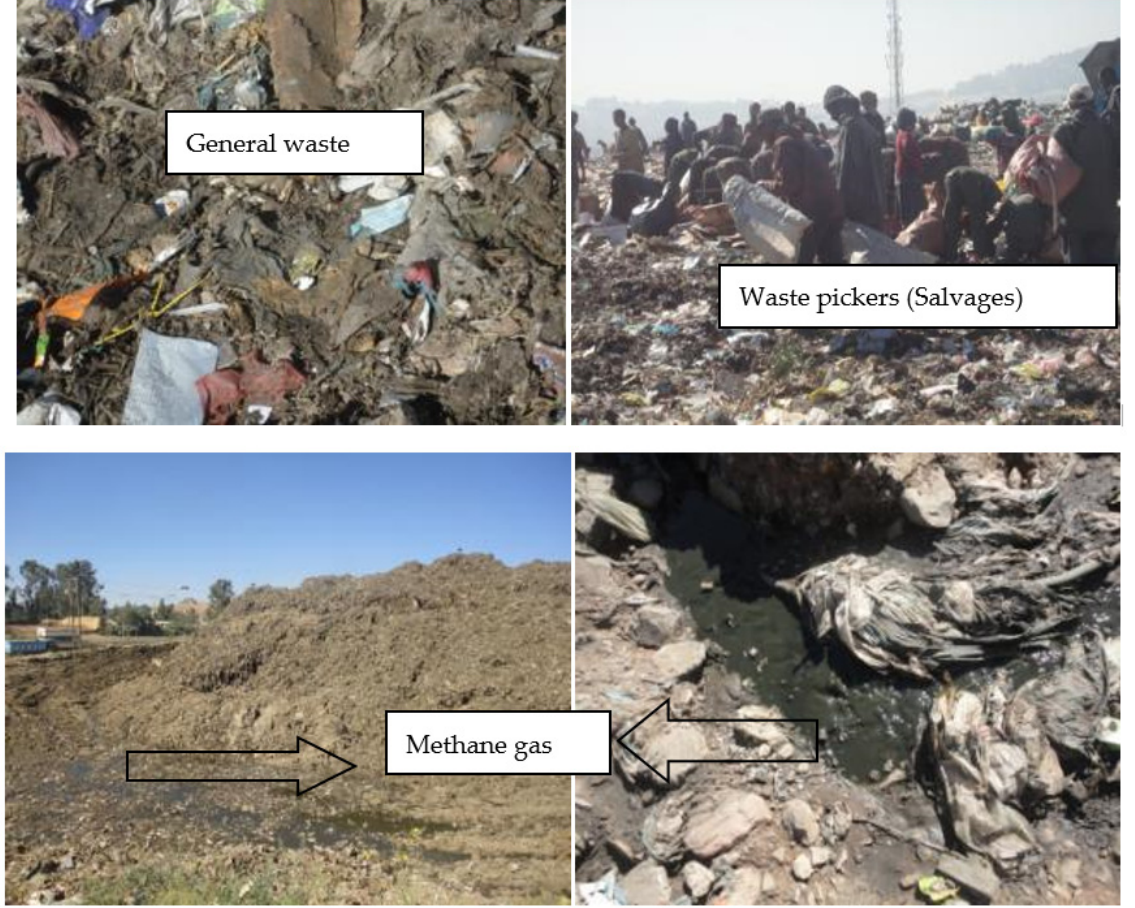
Figure 4. Reppi open landfill site.